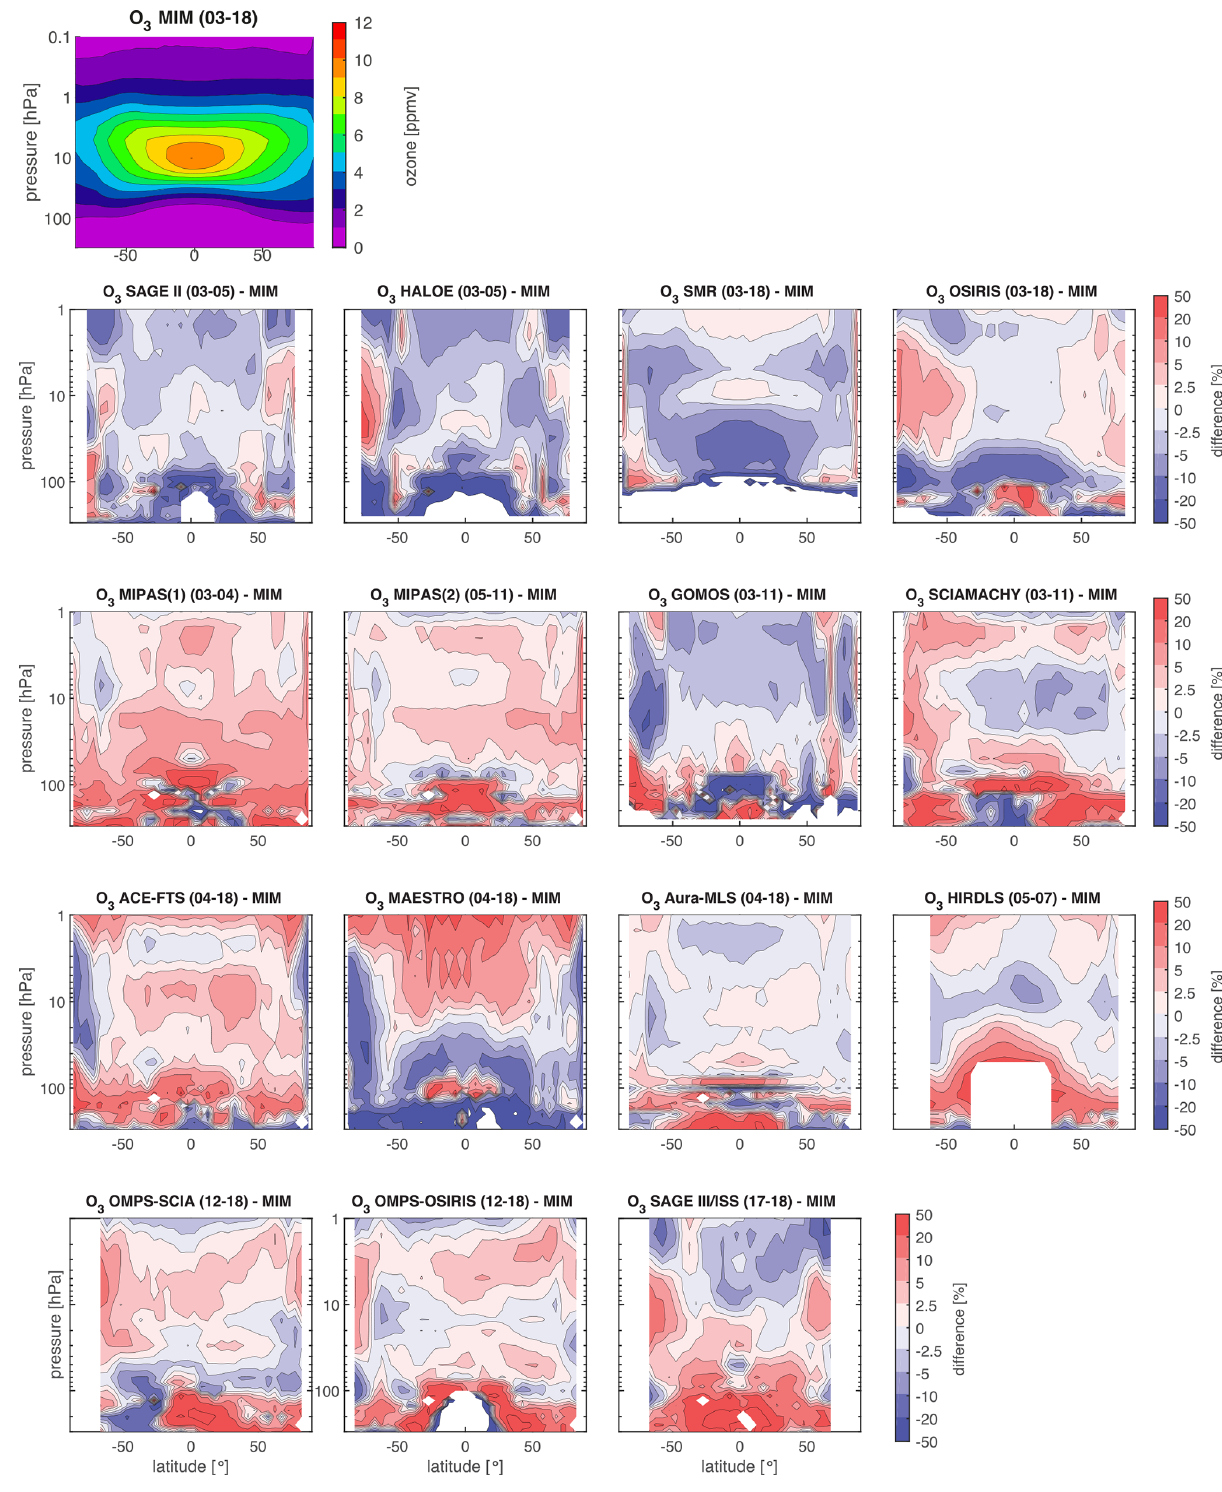
Figure 6. Cross sections of the MIM annual zonal mean ozone for 2003–2018 and differences between the individual instruments and the MIM are shown (update from Fig. 2 in Tegtmeier et al., 2013). The MIM includes SAGE II, HALOE, SMR, OSIRIS, MIPAS(1) and MIPAS(2), GOMOS, SCIAMACHY, ACE-FTS, ACE-MAESTRO, Aura-MLS, HIRDLS, IUP-OMPS, USask-OMPS-LP, and SAGE III/ISS. Note that while none of the instruments cover the full time period, detailed evaluations of shorter time periods (e.g., 2012–2018, 2005–2010) give very similar